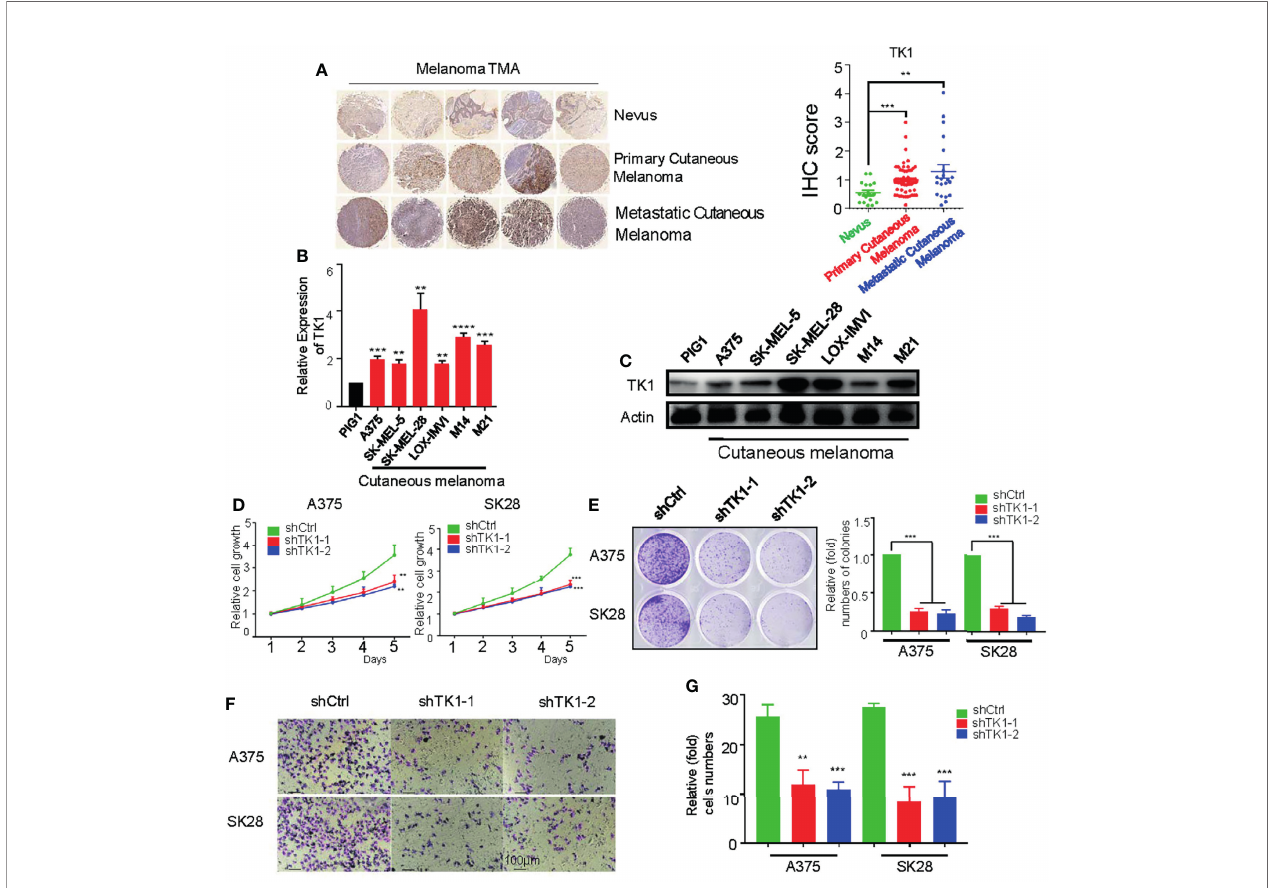
FIGURE 2 | A protumor role of thymidine kinase 1 (TK1) was con fi rmed in skin cutaneous melanoma cell lines. (A) Immunohistochemistry (IHC) staining on dozens of nevi, primary skin cutaneous melanomas (SKCMs), and metastatic SKCMs with respective fold change of TK1. (B) Relative mRNA expression of TK1 in different melanoma cell lines by quantitative real-time PCR (qRT-PCR). The experiments were performed in triplicate. (C) Relative protein expression of TK1 in different melanoma cell lines by Western blot. The experiments were performed in triplicate. (D, E) Cell Counting Kit-8 (CCK-8) assay and colony formation assay were conducted to con fi rm the in fl uence of TK1 on cell proliferation. The number at the fi rst day was set to 1 for every group. The experiments were performed in triplicate. (F, G) Transwell assay and statistics were analyzed to explore the in fl uence of TK1 on SKCM cell migration. The experiments were performed in triplicate. **p < 0.01, ***p <